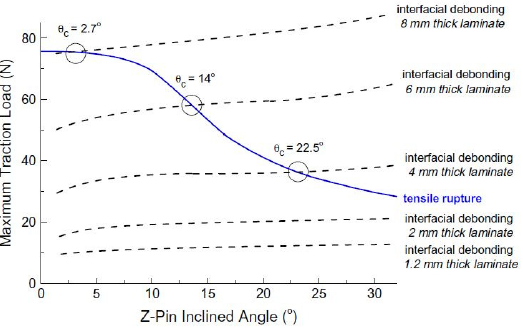
Figure 21. E ff ect of z-Pin embedment depth and o ff set angle on transition point from pull-out to F igure 21. Effect of z-Pin embedment depth rupture (CFRP z-Pins, d = 0.28 mm, [0 / 90] pre-preg) and offset angle on transition point from pull-out to rupture (CFRP z-Pins, d = 0.28 mm, [0/90] pre-preg) [13].